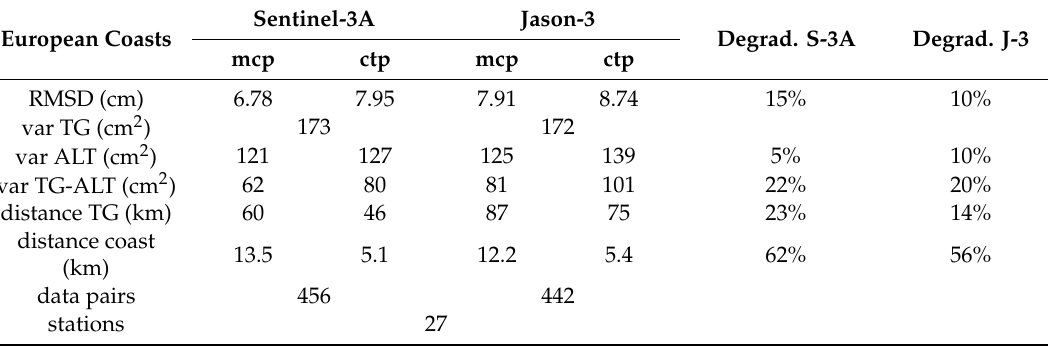
Table 4. The same as Table 1 but for the inter-comparison using the altimetry closest track point to coast (ctp) and the most correlated altimetry point (mcp) with tide gauge records computed along the satellite track of ctp (see text for details) for the twenty-seven common tide gauge stations showing a similar distance with the altimetry ctp for Sentinel-3A and Jason-3 (a maximum di ff erence of 1 km is allowed). The distance (km) of mcp and ctp to both tide gauges (TG) and coast and the degradation (in percentage) of the altimetry signal, computed as the di ff erences between mcp and ctp, are also shown. Sentinel-3A Jason-3 European Coasts Degrad. S-3A Degrad. J-3 mcp ctp mcp